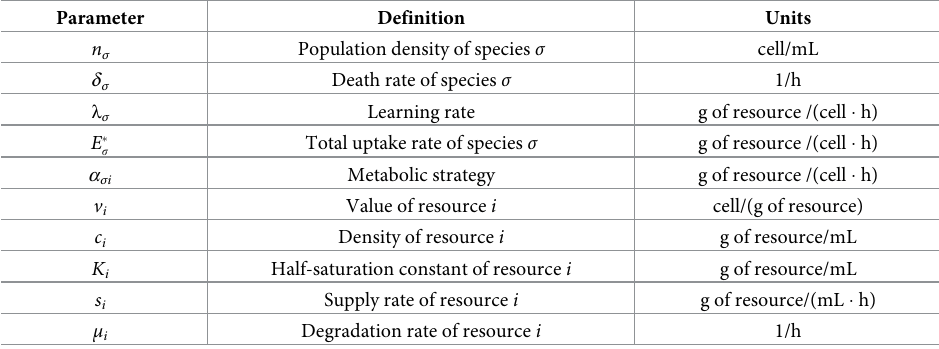
Table 1. Parameters used in our model, with their definition and units (see S1 Text for the detailed dimensional analysis of the model).